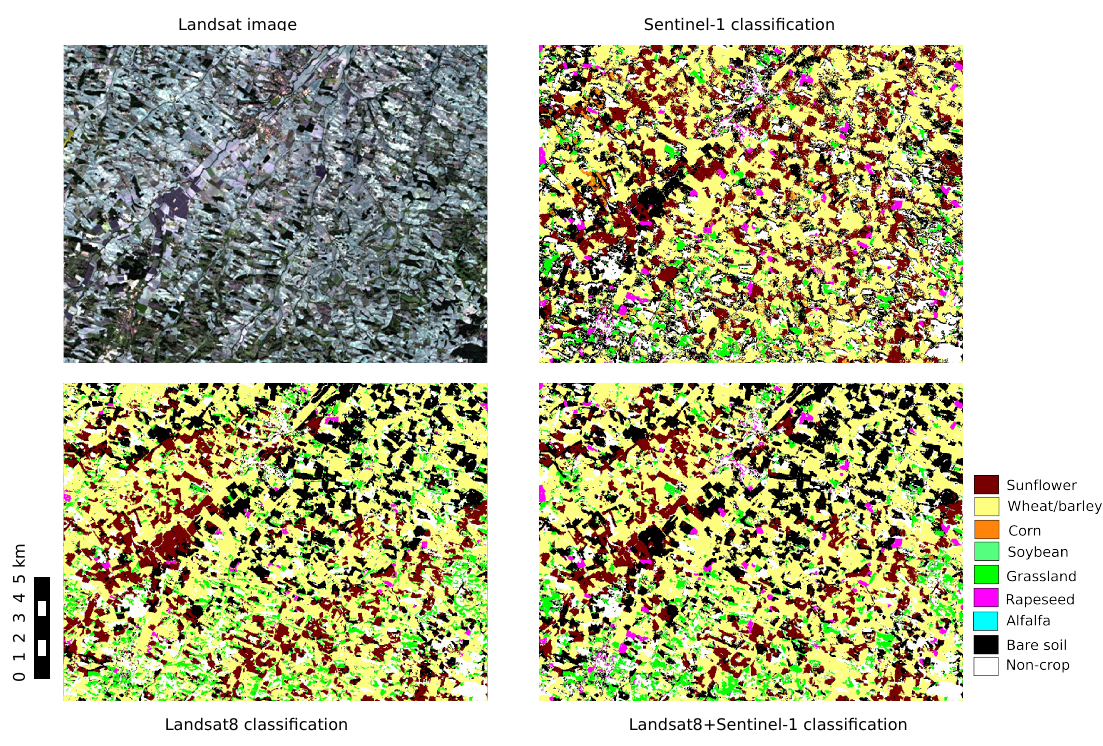
Figure 5. Land-cover maps at the end of the time series (extract). Landsat8 image ( upper left ), Sentinel-1 map ( upper right ), Landsat8 map ( lower left ), Sentinel-1 and Landsat8 map ( lower right